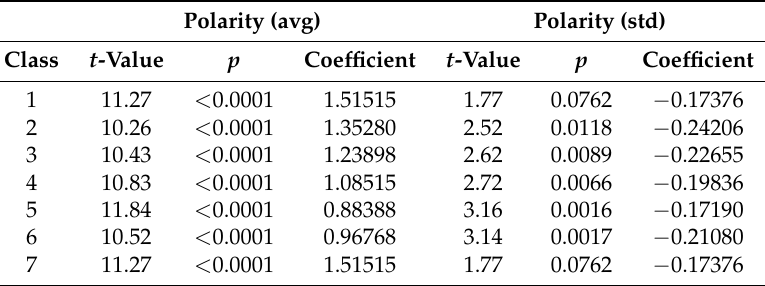
Table 7. Polarity contribution to score for different